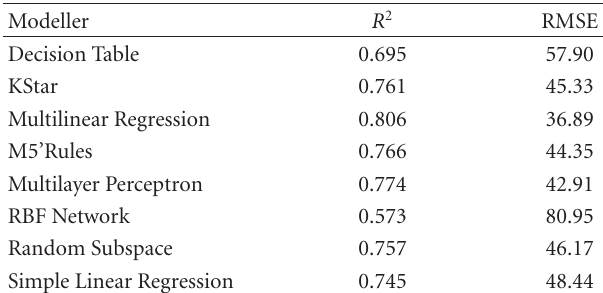
Table 4: The performance criteria of the models having 4-input